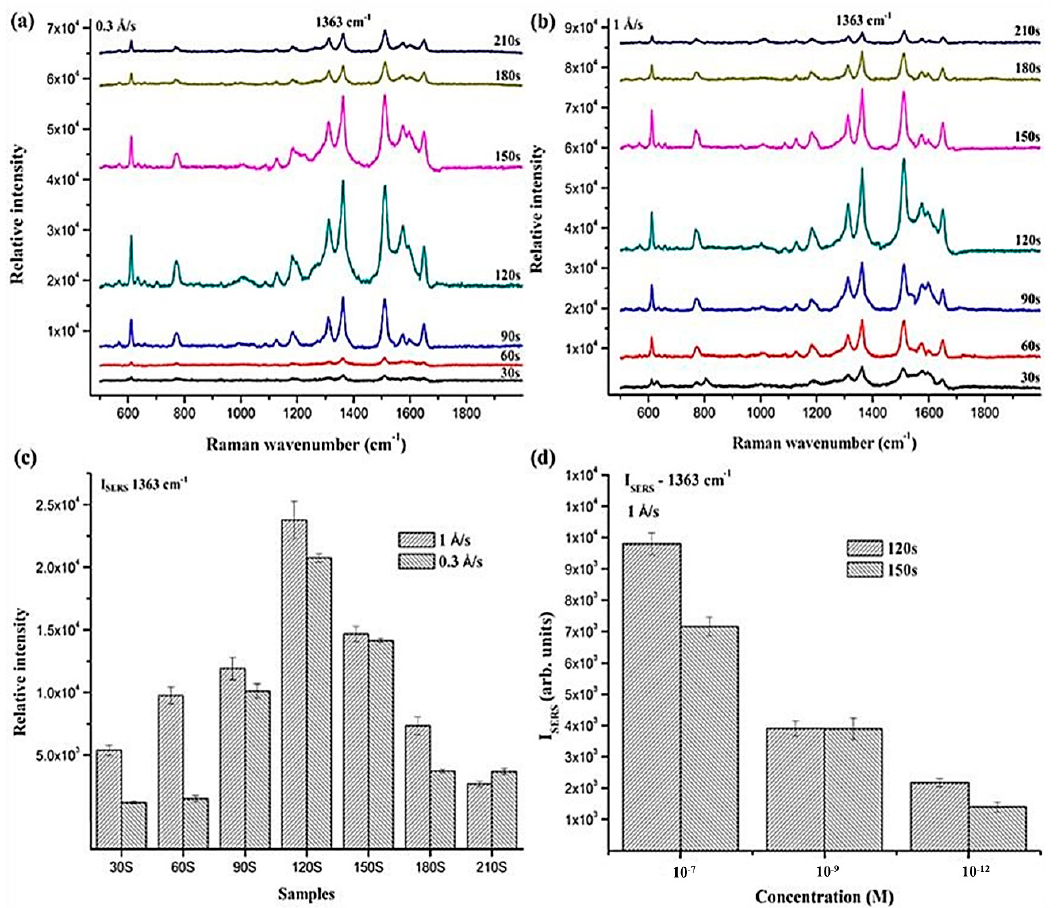
Figure 3. Surface-enhanced Raman spectroscopy (SERS) spectra of 10 − 6 M R6G molecule on as-fabricated Au nanoporous substrates with the deposition rates of ( a ) 0.3 and ( b ) 1 Å/s were taken with different dealloying times and examined at a Raman laser wavelength of 633 nm. ( c ) The SERS characteristic peak at 1363 cm − 1 was present with intensities for various deposition rates and dealloying times. ( d ) The SERS spectra of R6G molecules (10 − 7 , 10 − 9 , and 10 − 12 M) on an optimized Au nanoporous substrate were examined at a Raman laser wavelength of 633 nm. The relationship of relative Raman intensities with the concentration of the R6G molecule on an optimized Au nanoporous substrate was shown using I SERS peaks at 1363 cm − 1 .